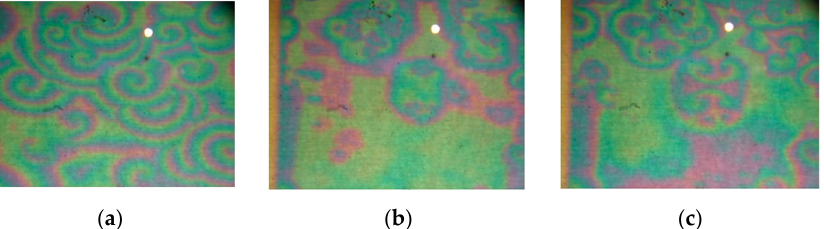
Figure 6. Modulation of the reverberator rotation frequency under the influence of a periodic ex- ternal force: ( a ) autowave process without external periodic influence and ( b , c ) rotation of the re- verberator under additional external periodic action. under additional external periodic